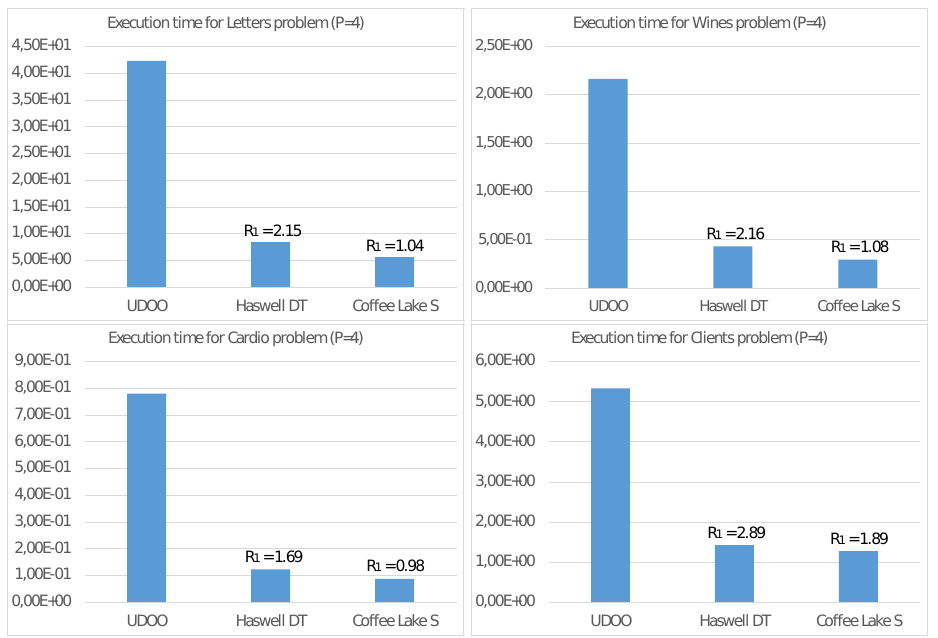
Figure 6. Execution time (in seconds) and energy consumption ratio R 1 of two high-end CPU compared with the UDOO X86 Advanced+